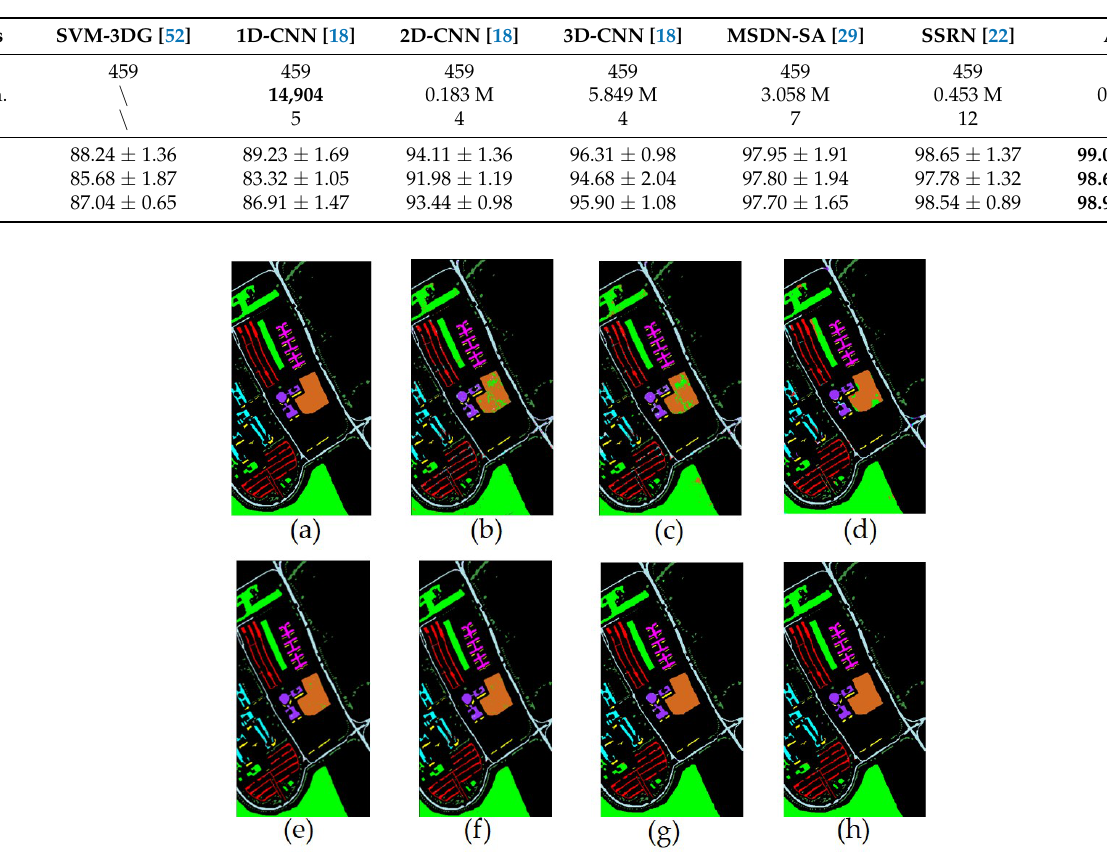
Table 8. Classification results for the KSC dataset.